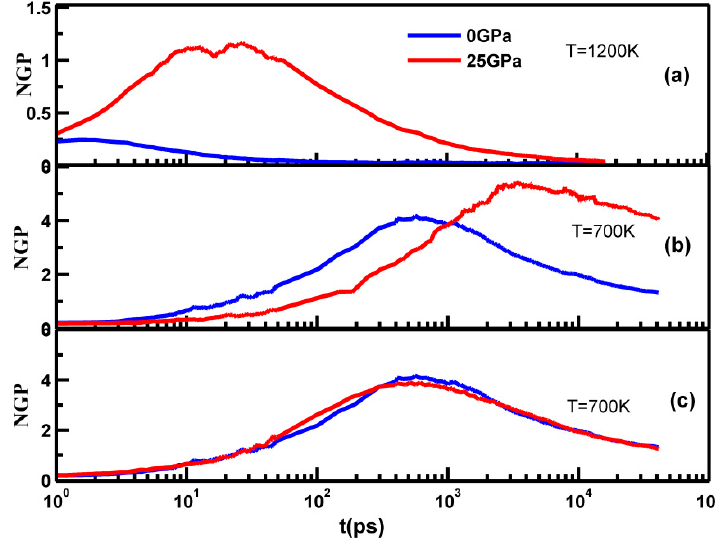
Figure 5. ( a ) Non-Gaussian parameter (NGP) curves of the samples quenched at 1200 K without pressure release; ( b ) NGP curves of the samples quenched at 700 K without pressure release; ( c ) NGP curves of the samples quenched at 700 K after pressure release with 0 GPa.